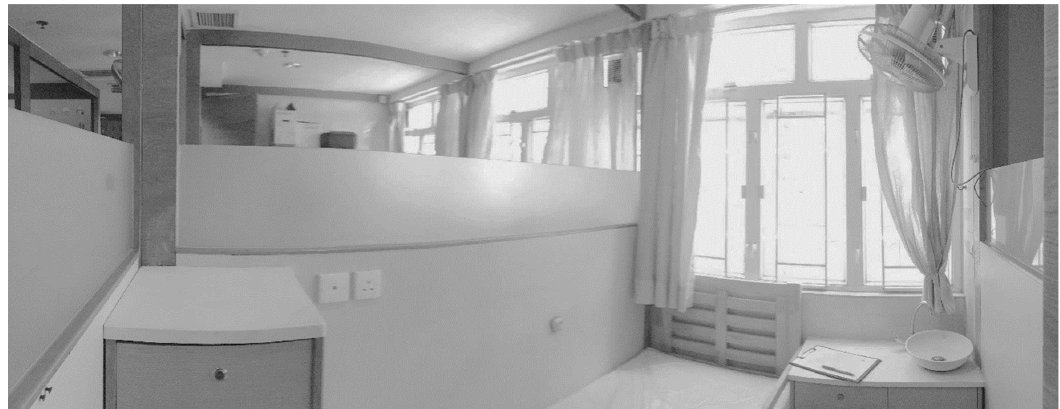
Figure 4. Typical chamber of C&A homes in Hong Kong (photo by the authors).